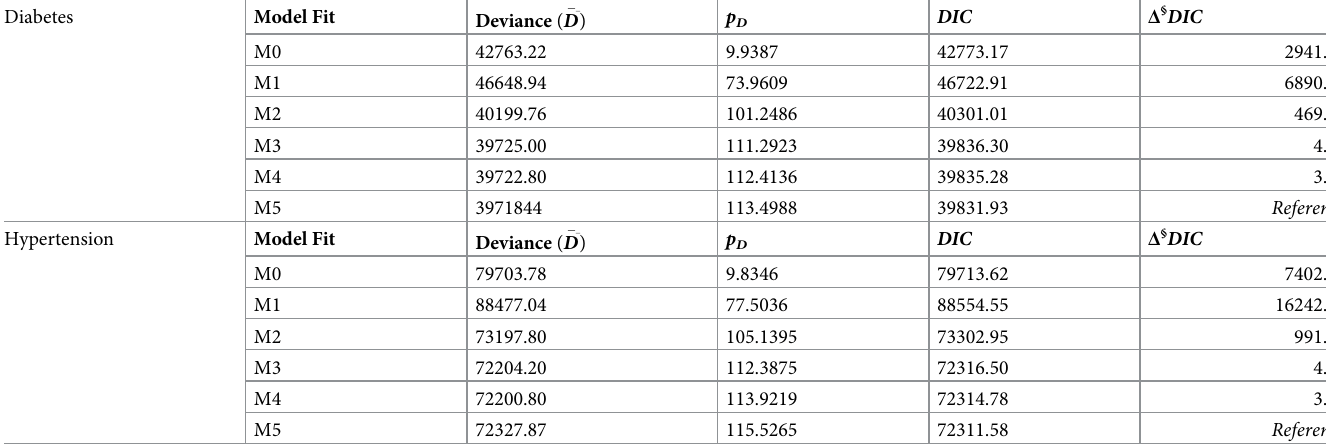
Table 2. Comparison of models based on deviance information criterion (DIC).